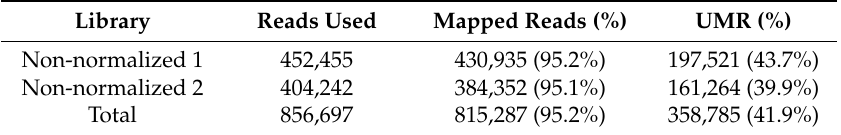
Table 2. Results obtained for read mapping, with BWA, against the transcriptome assembly. Library Reads